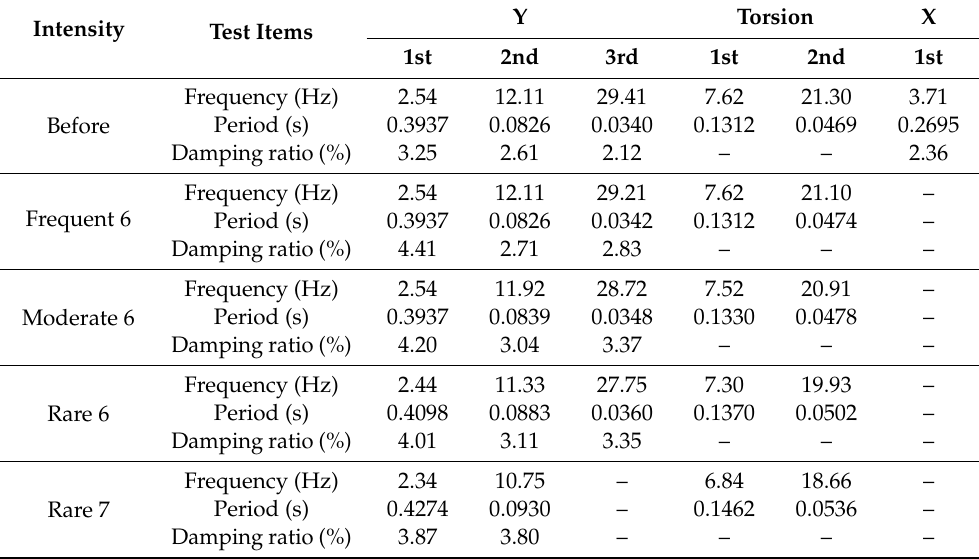
Table 6. Dynamic characteristics of the model before and after the